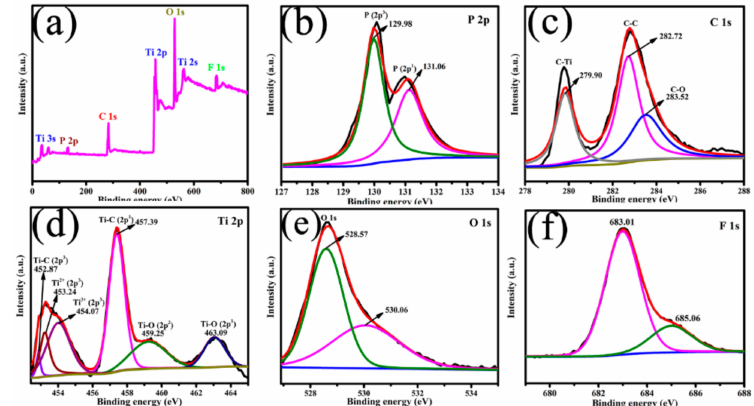
Figure 6. ( a ) XPS survey spectra and high resolution XPS spectra of ( b ) P 2p, ( c ) C 1s, ( d ) Ti 2p, ( e ) O 1s, ( f ) F 1s of BTTC-120